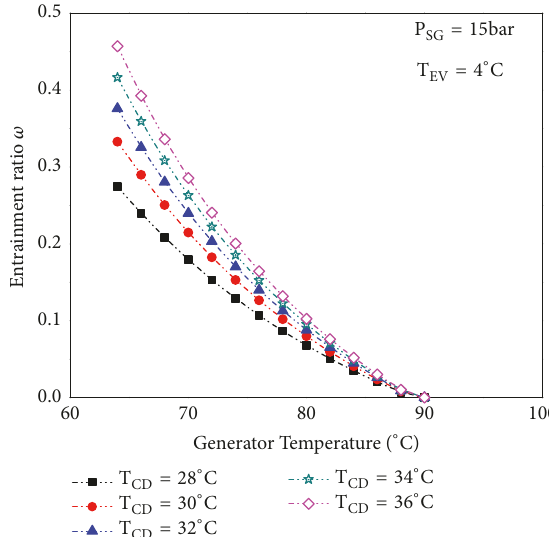
𝜔 vs . 𝑇 𝐺 for various condenser temperature